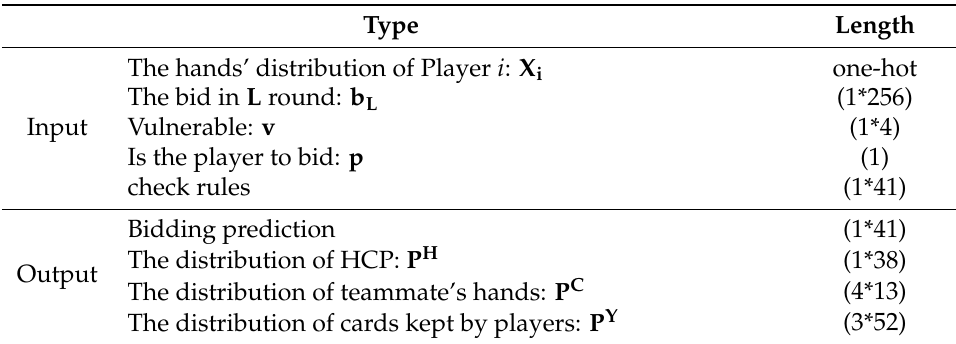
Table 1. Parameters for